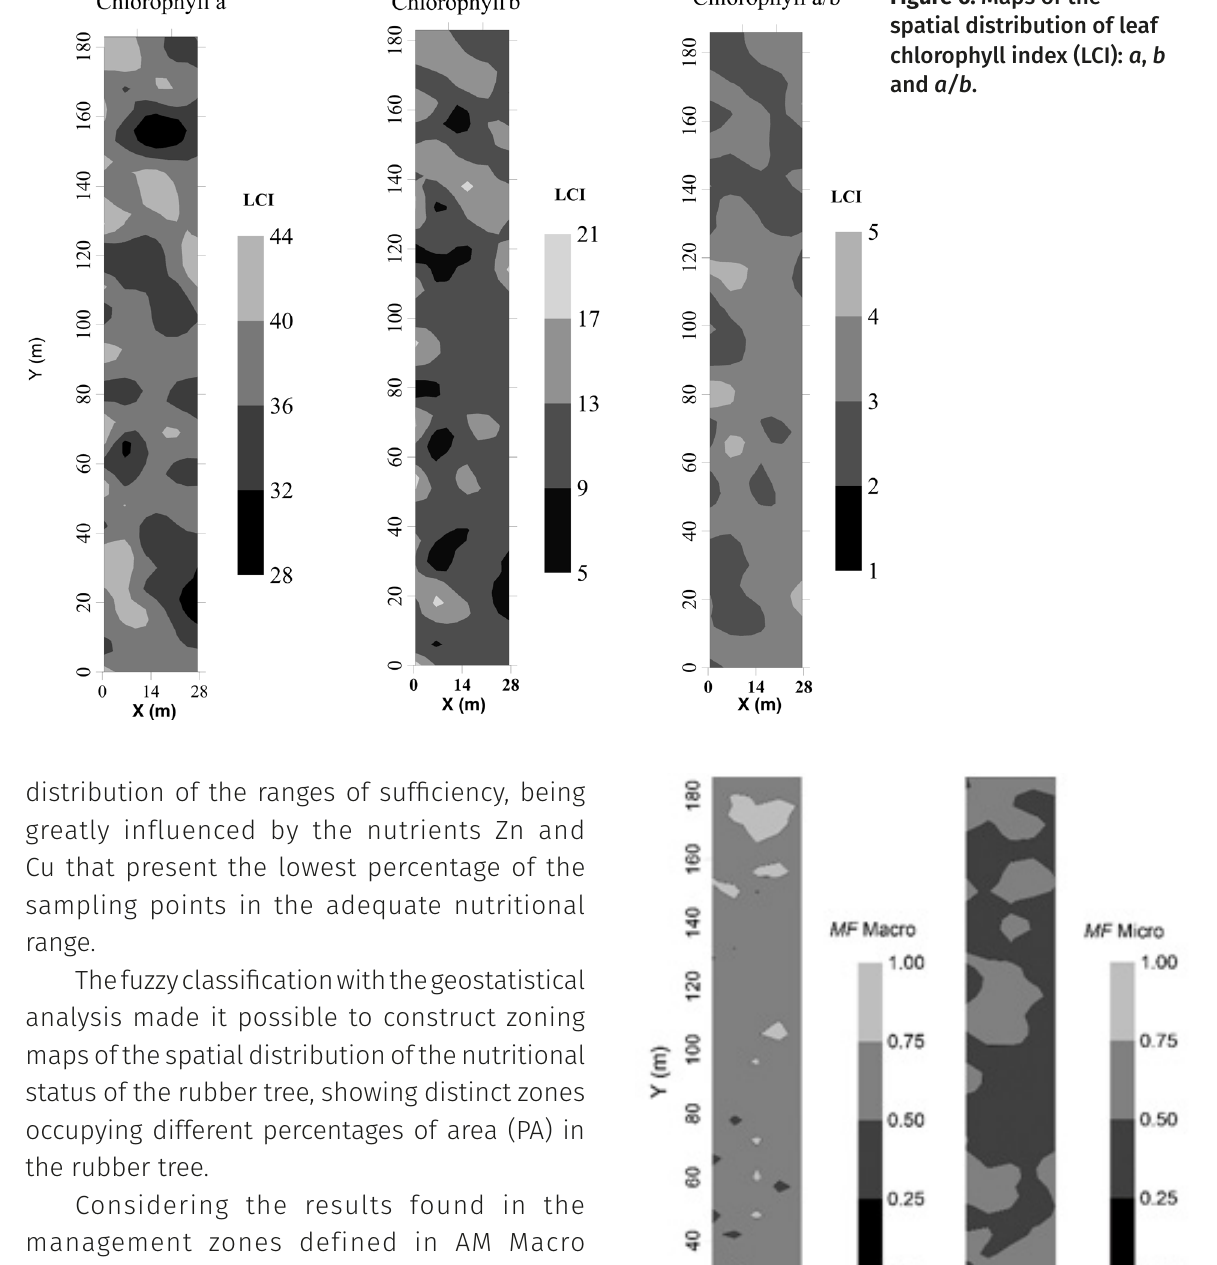
Figure 6. Maps of the spatial distribution of leaf chlorophyll index (LCI): a , b and a/b .